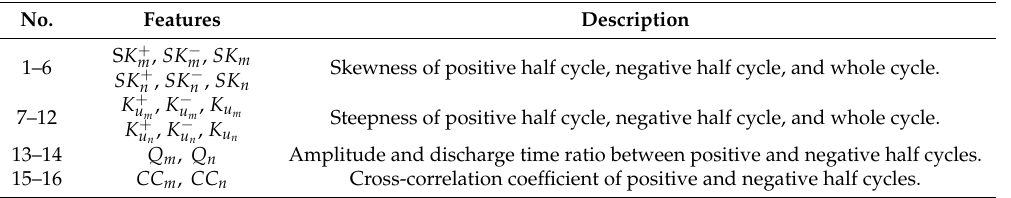
Table 2. Statistical characteristics under PRPD mode.